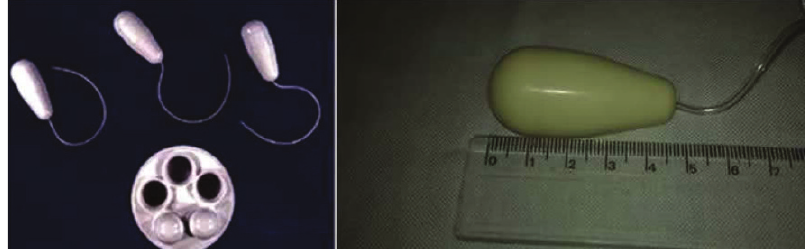
Figure 1 - Vaginal